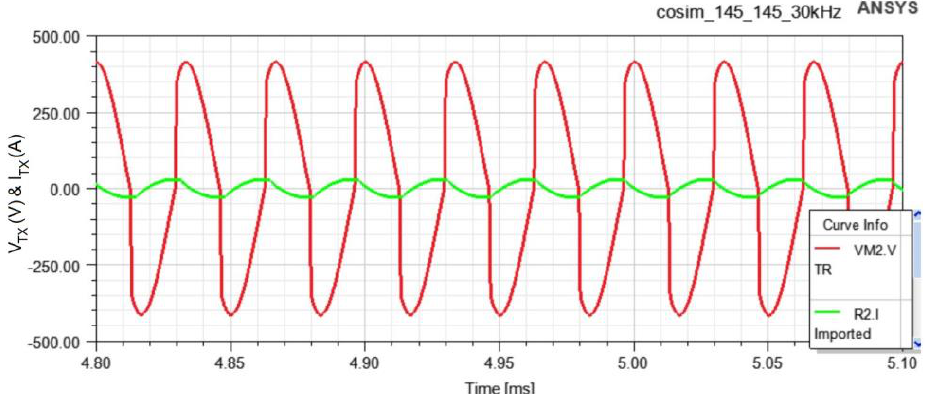
Figure 13. Voltage (red) and current (green) waveform of the transmitter coil.